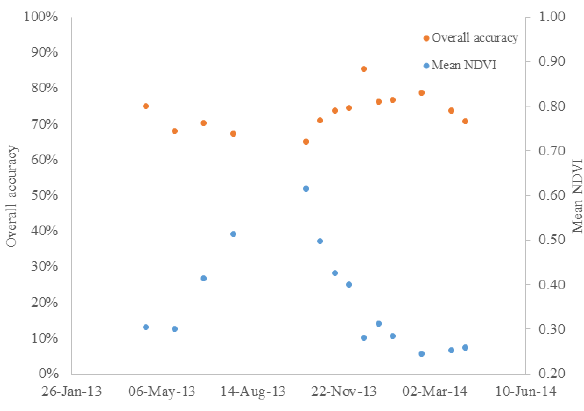
Figure 3. Overall accuracy and mean NDVI for each image.